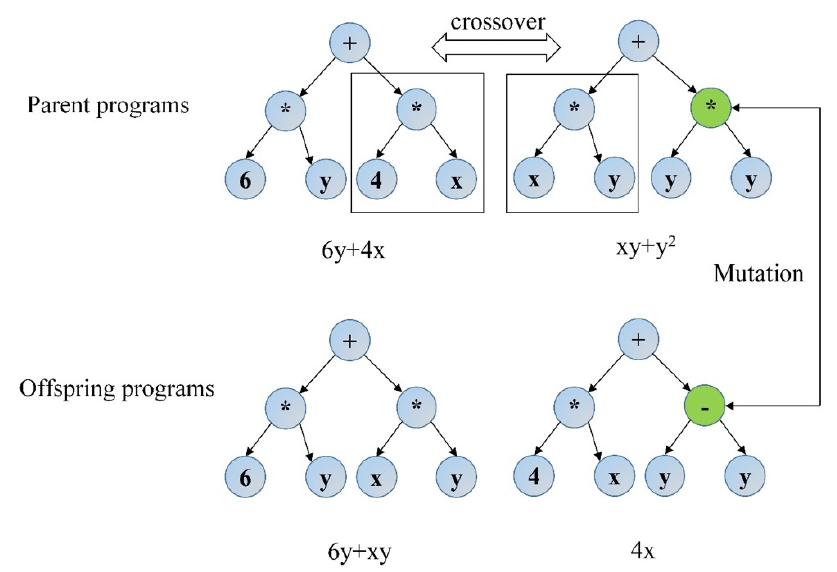
Figure 3. Tree structures illustrating crossover and mutation in GP.